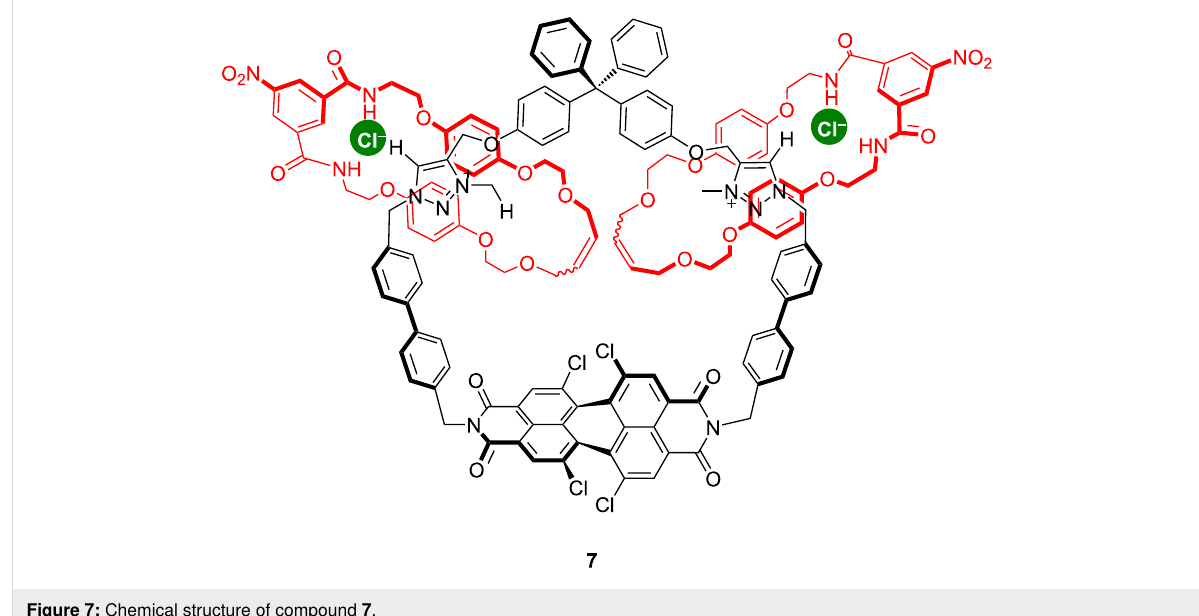
Figure 7: Chemical structure of compound 7 .